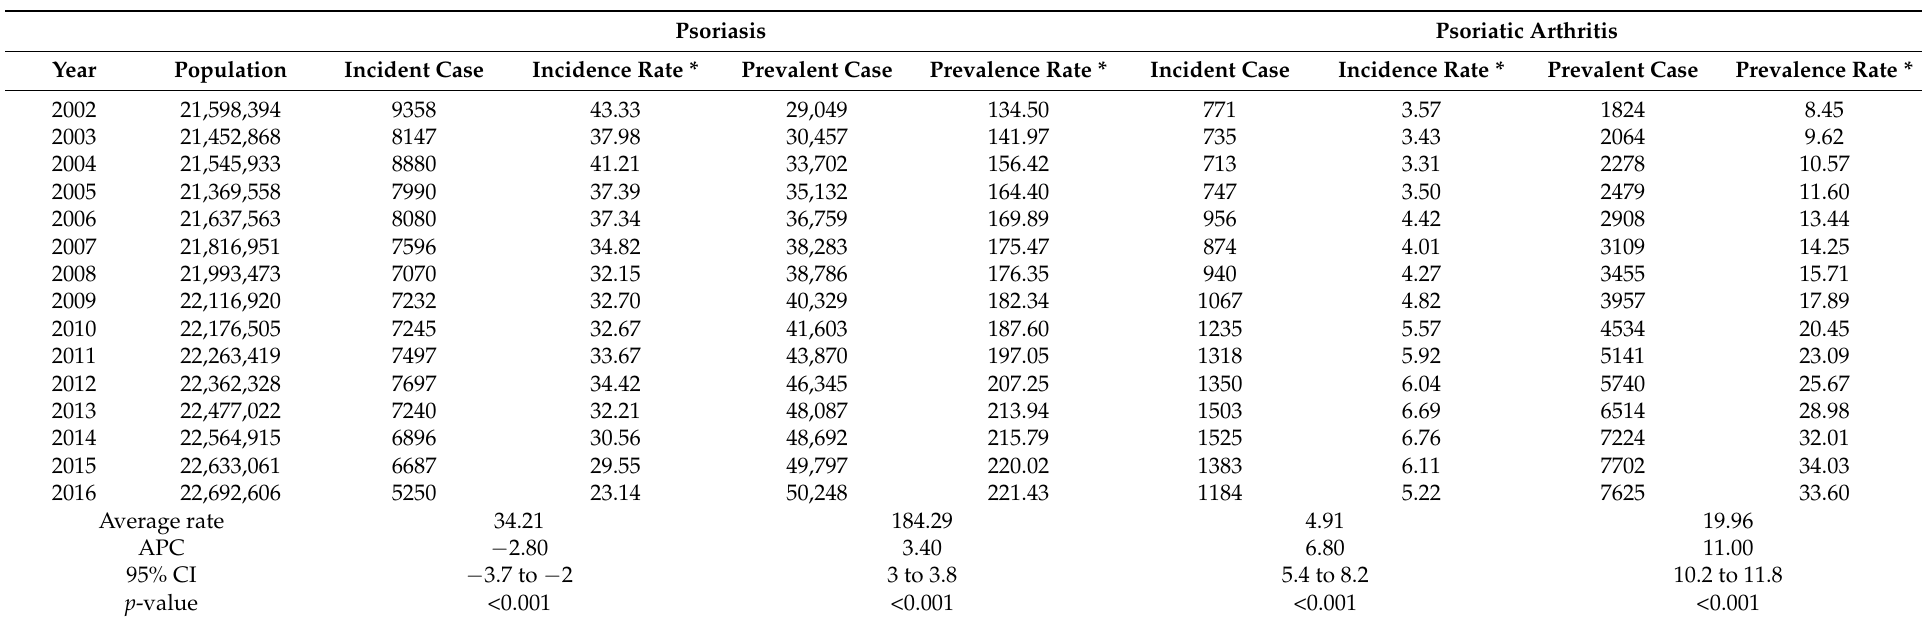
Table 1. Incidence and prevalence of psoriasis and psoriatic arthritis.